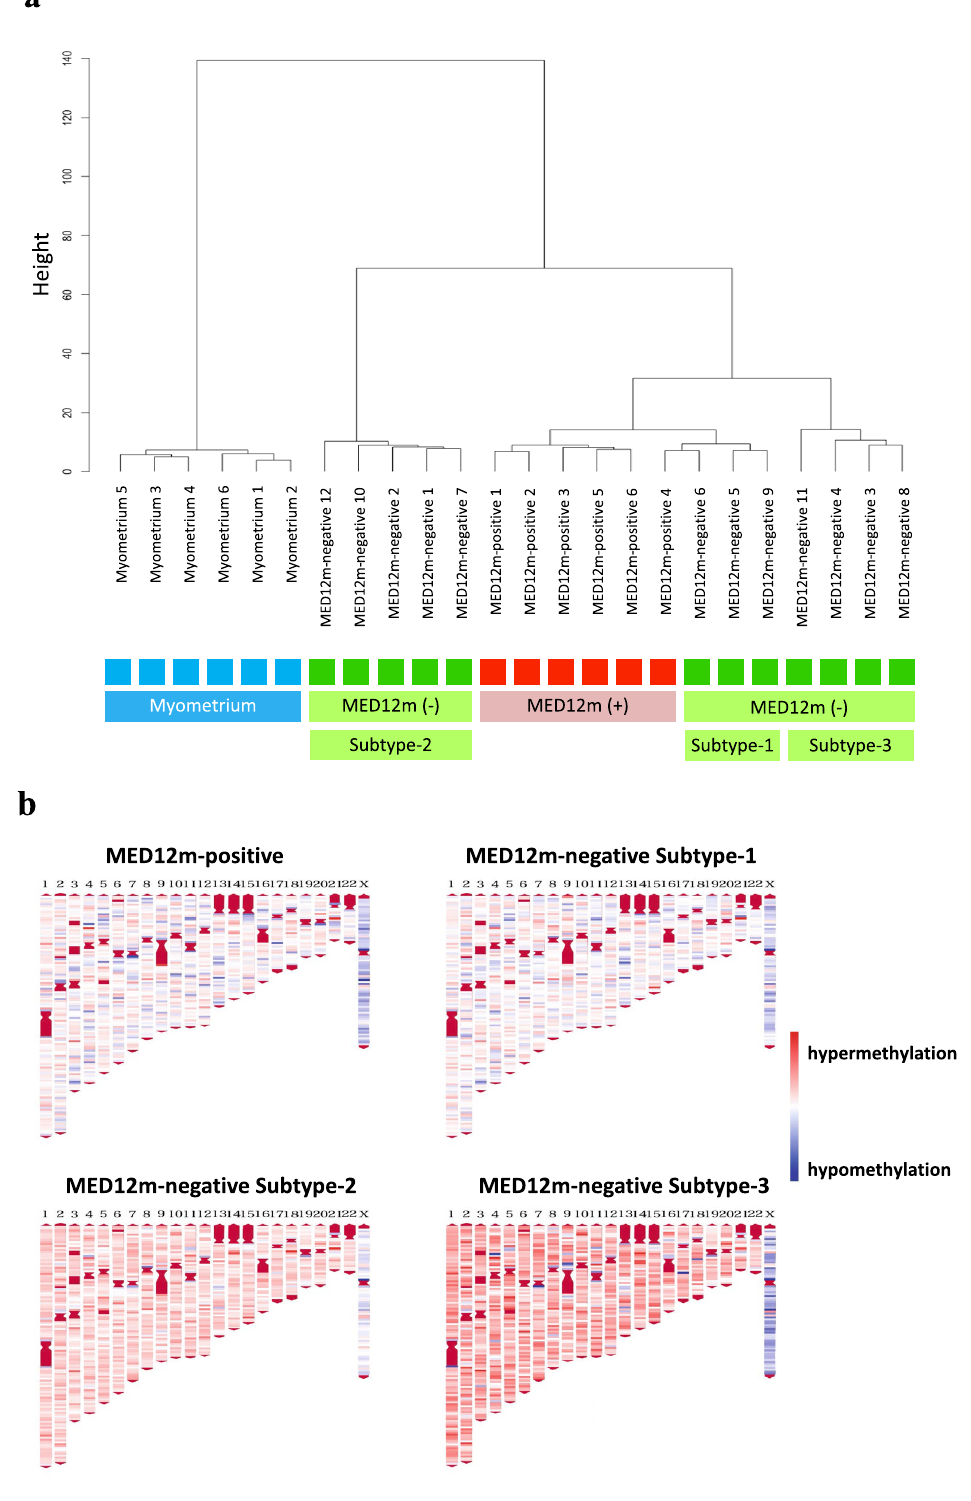
Figure 1. DNA methylation profiling of the MED12m-positive and -negative uterine fibroids, and myometrium. ( a ) DNA methylation profiles of the MED12m-positive and -negative uterine fibroids, and myometrium were compared using hierarchical clustering analyses. Distances of DNA methylation pattern are indicated as height. Each color indicates the myometrium (light blue), the MED12m-positive uterine fibroids (red), and the MED12m-negative uterine fibroids (green). The MED12m-negative uterine fibroids were further classified into three different clusters, Subtype-1, Subtye-2, and Subtype-3. ( b ) Chromosomal distribution of hyper- or hypomethylated CpGs in the MED12m-positive and -negative uterine fibroids (Subtype-1, -2, and -3) compared to the myometrium are shown. The locations of CpG sites, which have p < 0.05 and beta-value difference > 0.2 compared to the myometrium, are indicated with red (hypermethylated CpGs) or blue (hypomethylated CpGs). Autosomal and sex chromosome numbers are shown on the